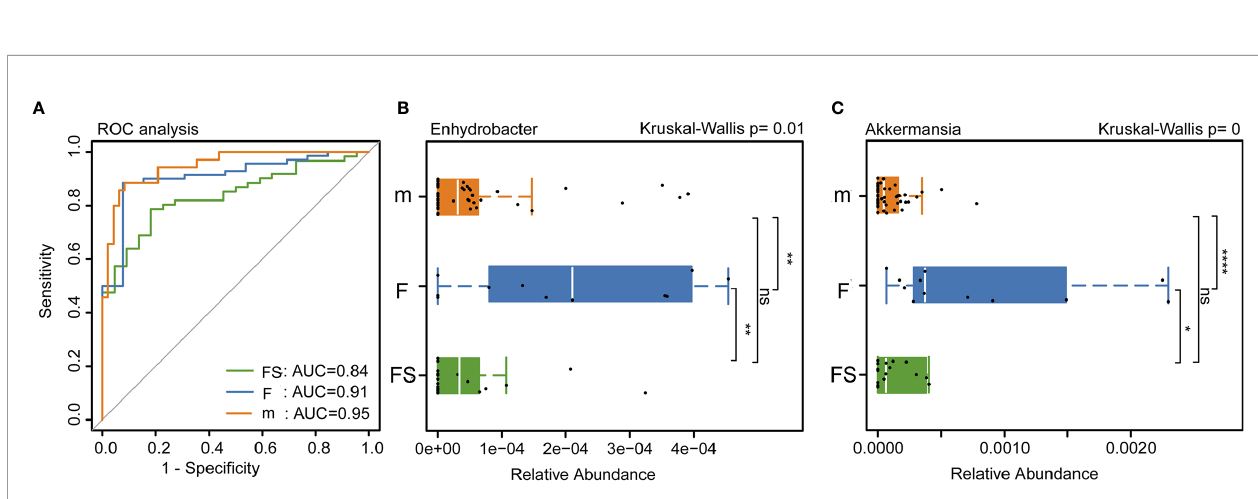
FIGURE 4 | Analysis of intestinal bacteria that affect the health of newborns. (A) Accuracy of bacterial classi fi cation assessment by ROC curve. (B) Relative abundance of Enhydrobacter in three groups. (C) Relative abundance of Akkermansia in three groups. fs, supplemented formula group (n = 22); f, standard formula group (n = 13); m, breastfeeding group (n = 48). *(p < 0.05); **(p < 0.01); ****(p < 0.0001); ns, no signi fi cant.